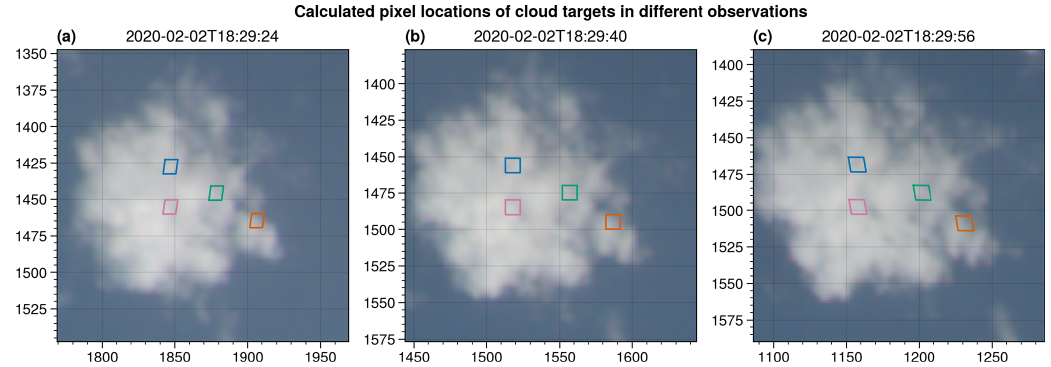
Figure 11. Calculated pixel positions of cloud targets, indicated by different colors, in observations at different times during the overflight.